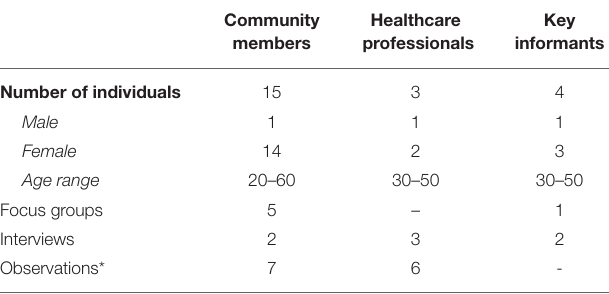
TABLE 1 | Basic sample characteristics and field activities performed. Community members